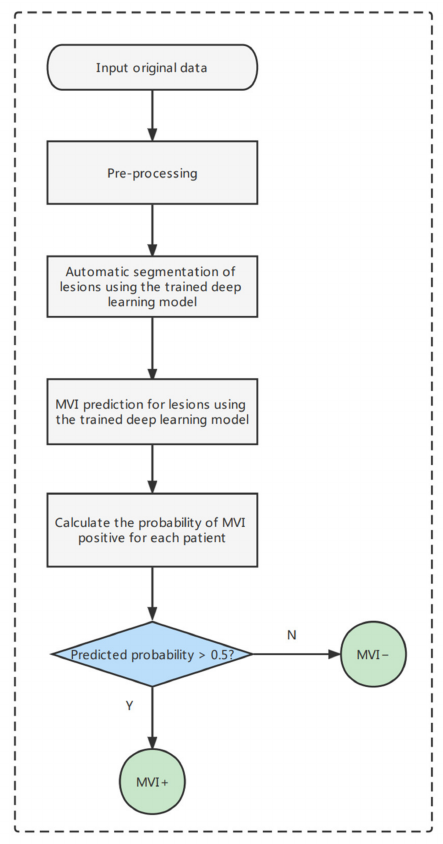
Figure 7. End-to-end prediction pipeline of